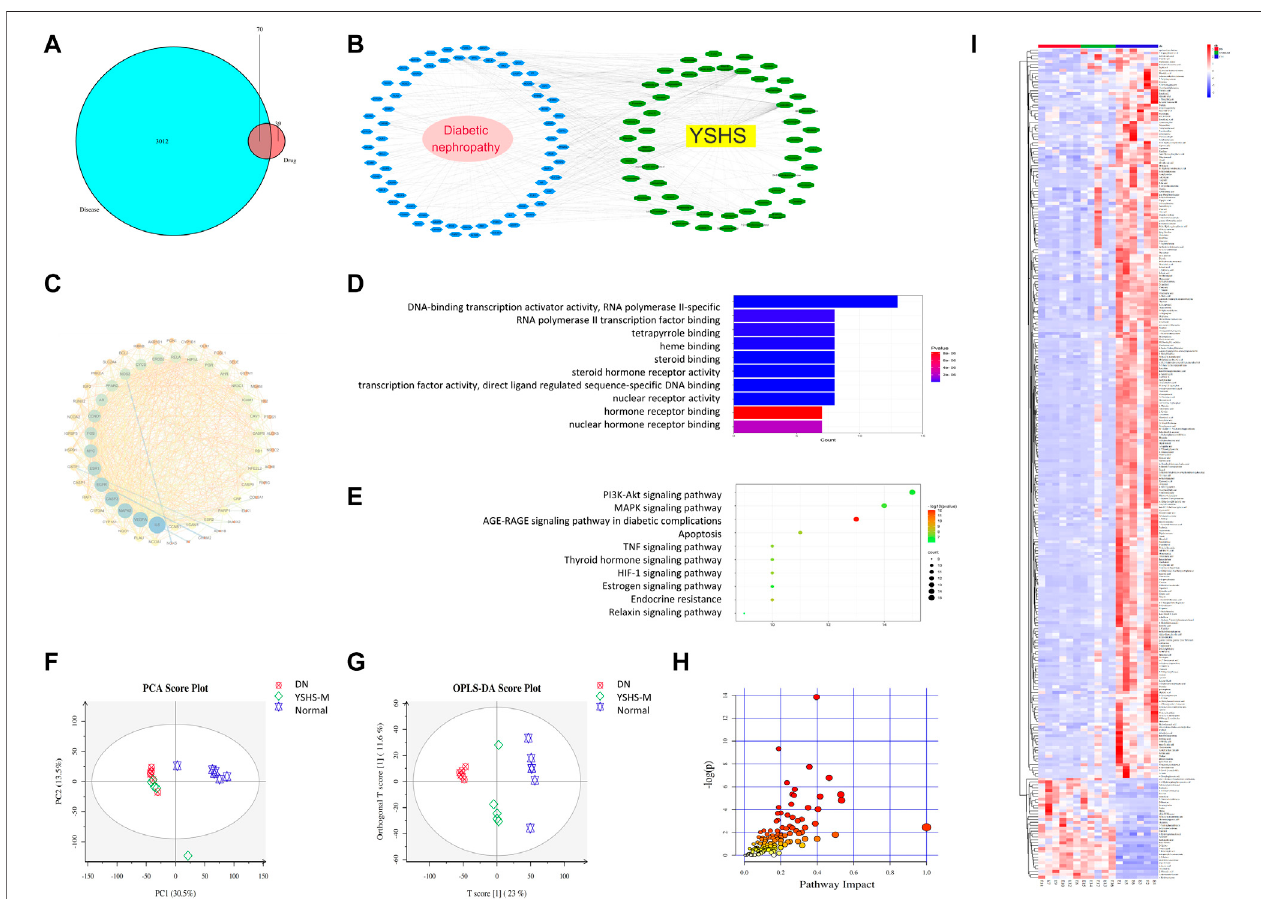
FIGURE5| Networkpharmacologyanalysisanddifferentialmetaboliteanalysisofurine.VenndiagramofdiseasesandYSHSdrugs (A) .Compoundtargetdisease (CTD)networkofYSHS (B) ;thegreencirclesrepresentcompoundtargets,andthebluecirclesrepresentdiseases.ThePPInetwork (C) wassortedindescendingorder fromthebottomofthe fi gureinacircularlayout,onthebasisofthenumberofdegrees;thesizeofthetargetanddiseasenodesre fl ectsthenumberofdegrees.Biological processes related to targets of YSHS (D) . Pathway analysis using the Kyoto Encyclopedia of Genes and Genomes (KEGG) (E) . Metabolomic analysis of rat urine: Separationofraturine inaPCA scoreplot (F) ;loadingS-plot generatedbyOPLS-DA analysisofthemetabolomeinraturine (G) ; differential metabolite pathway analysis (H) differential metabolite heat map of the urine among groups (I) .